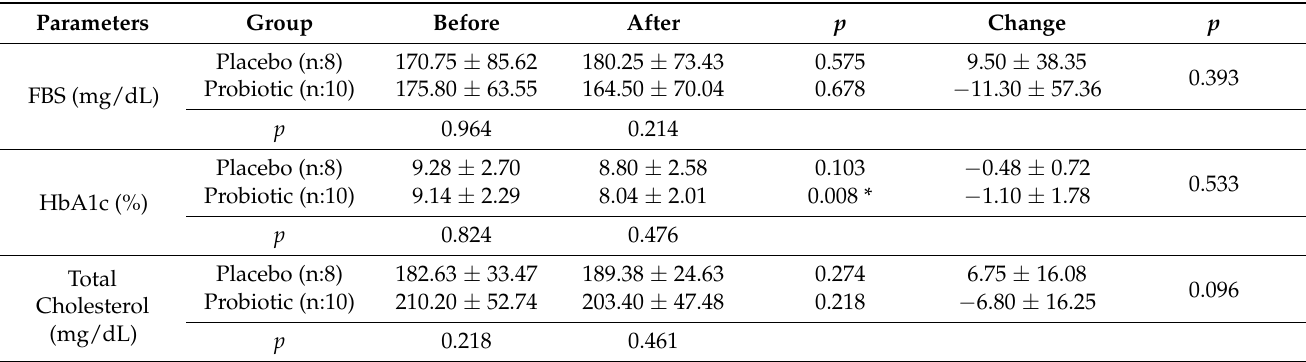
Table 8. Metabolic profiles before and after intervention in both